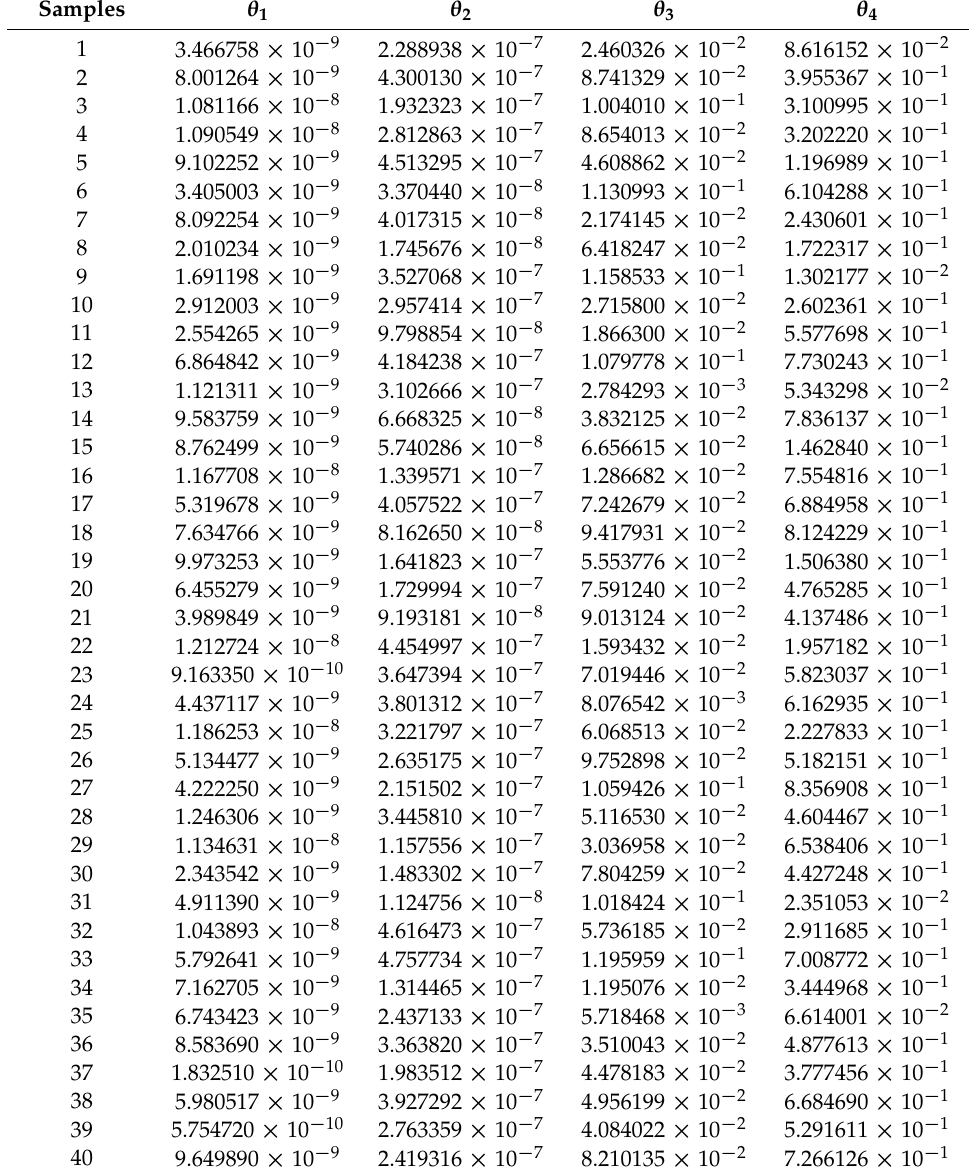
Table 2. Sampling data set as inputs into the simulator ABM, where θ k , k = 1,2,3,4 represent proliferation rate, infection rate and death rate per hour for epithelial cells, infected epithelial cells, and virus,